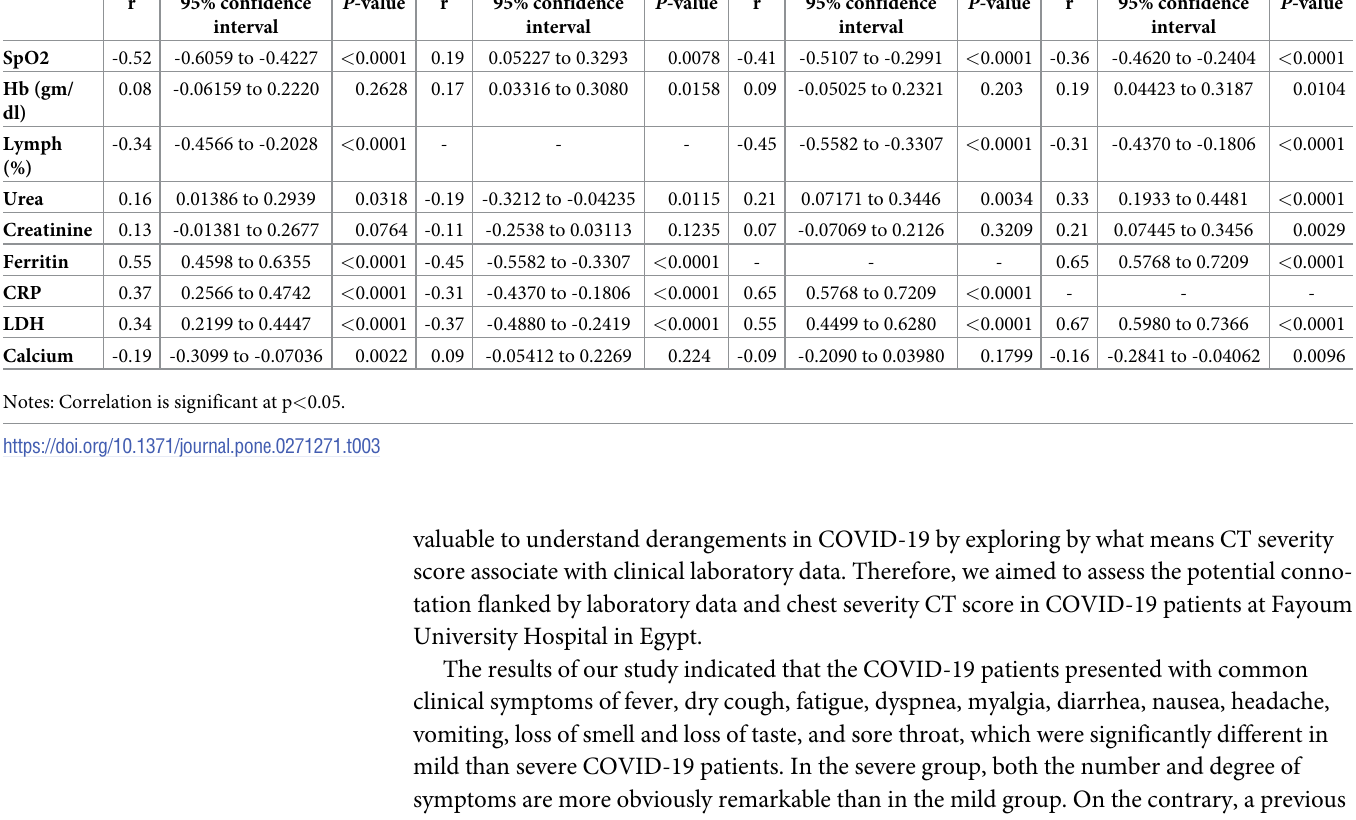
Table 3. Correlation between clinical laboratory data and CT severity score in COVID-19 patients at Fayoum University Hospital in Egypt. CT severity score (points)